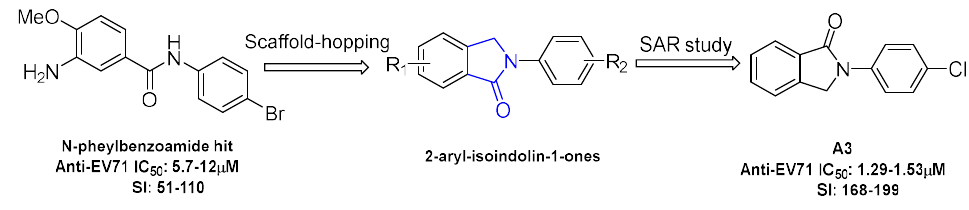
Figure 1. Structure modification strategy of anti-enterovirus 71 (EV71) compounds.